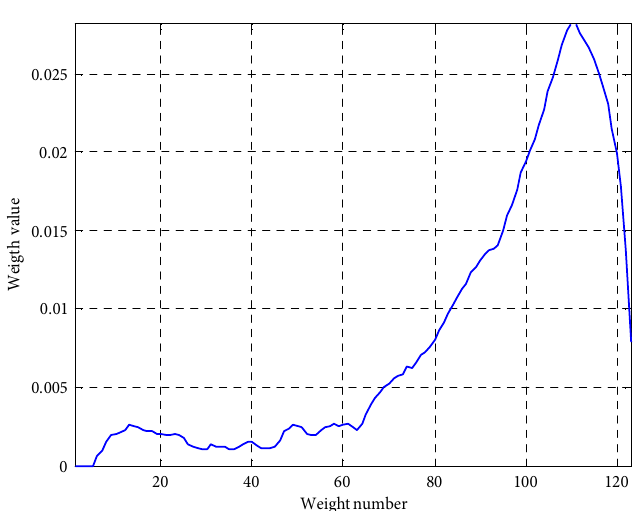
Fig. 8. Very long (123) CMA weight